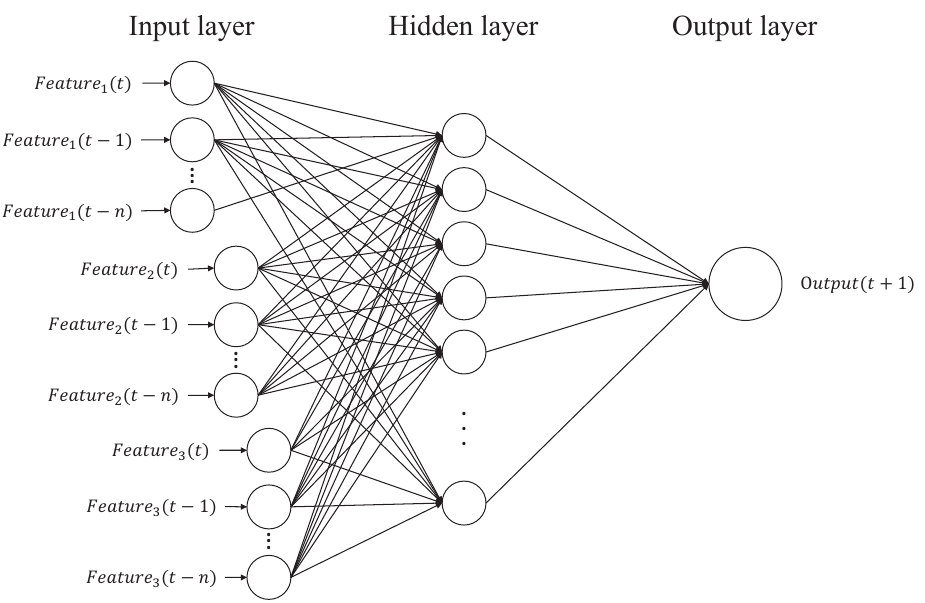
Figure 3. A fully connected feed-forward Back-Propagation Neural Network with